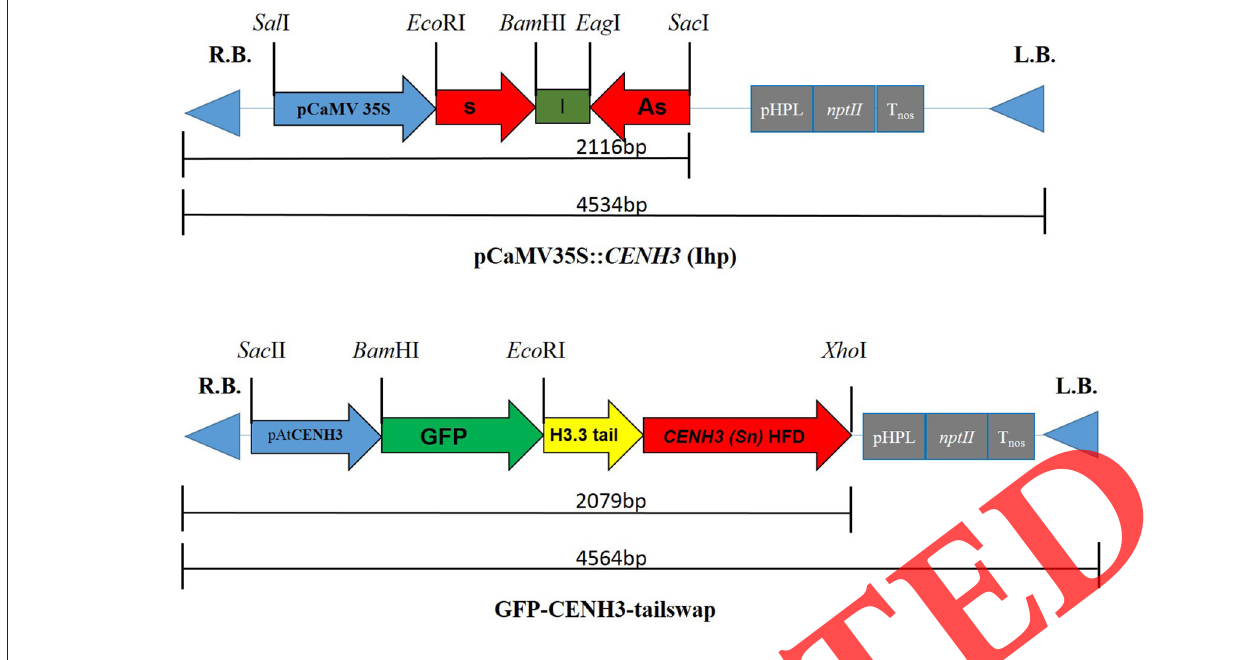
FIGURE 2 | Schematic representation of T-DNA region of RNAi (pCaMV35S::CENH3) (Ihp) and GFP-synthetic CENH3-tailswap constructs. pCaMV35S- Cauliflower mosaic virus 35S promoter, s- CENH3 CDS sequence in sense direction, I-catalase intron, As- CENH3 CDS sequence in antisense direction, pAtCENH3-